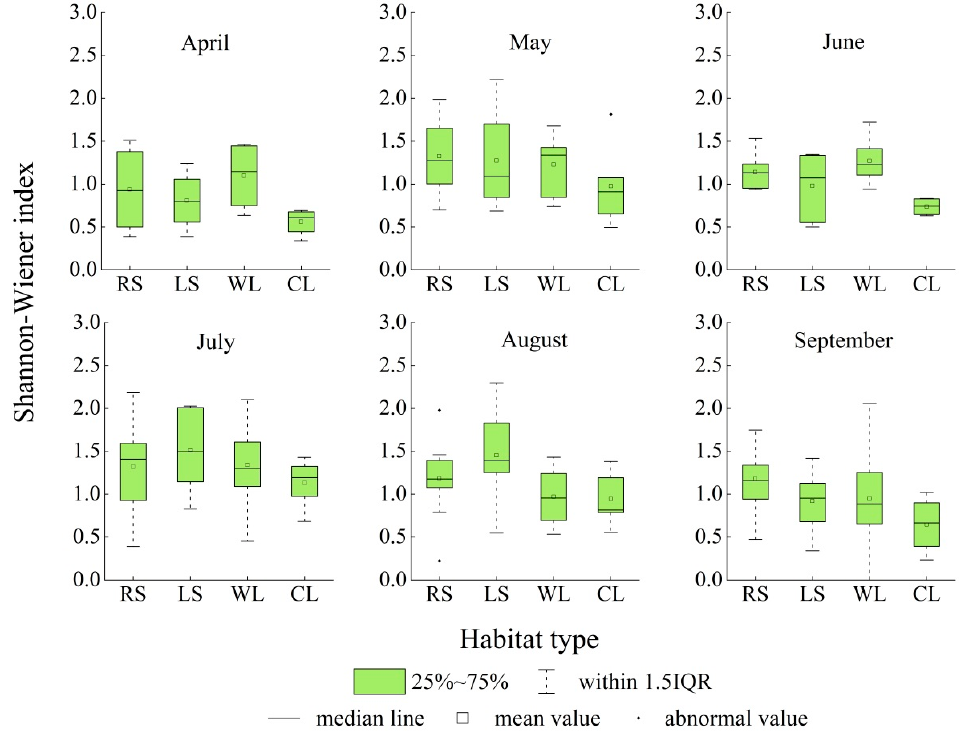
Figure 9. Range of variation and monthly medians for the Shannon–Wiener diversity index in different habitats of the Tangdao Bay National Wetland Park from April to September.